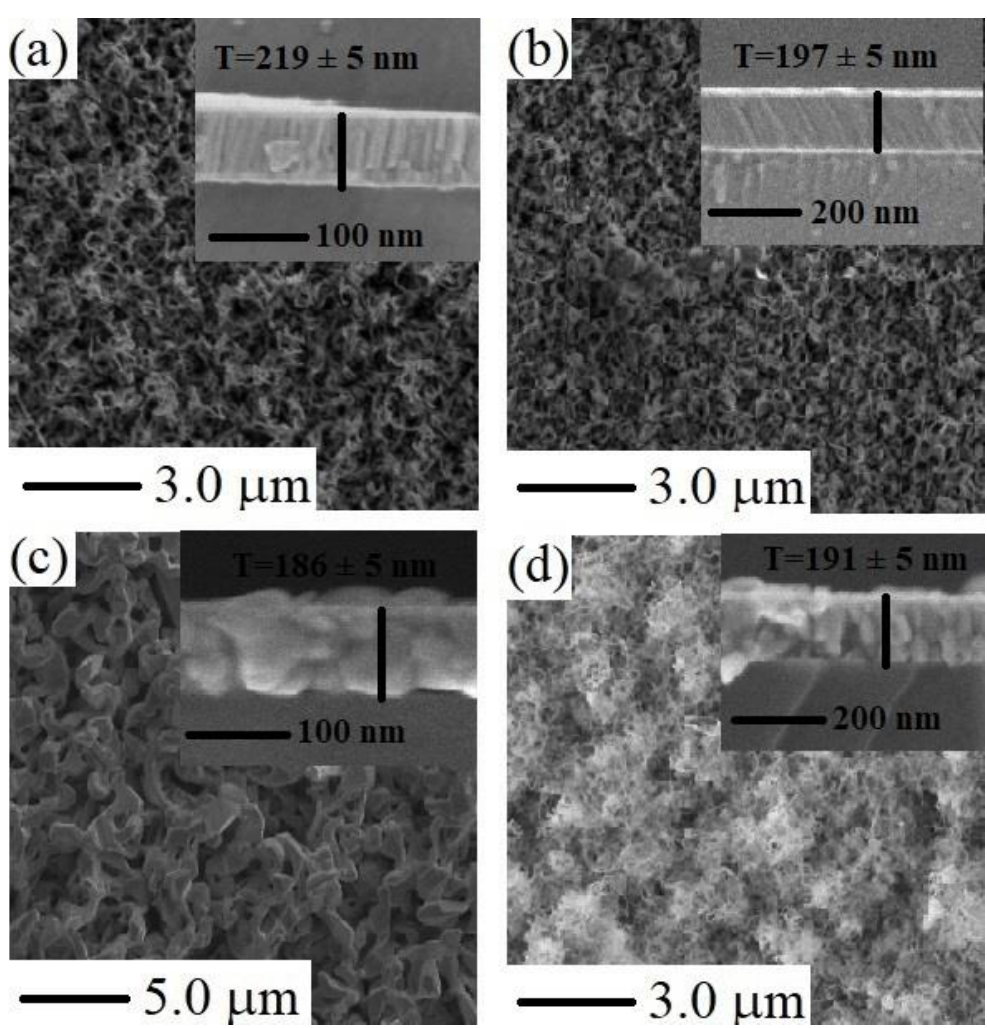
Figure 3. SEM images of ZnS thin films deposited at ( a ) 20 mm, ( b ) 40 mm, ( c ) 60 mm, and ( d ) 80 mm SSD. Insets show the cross-sectional zoom in micrographs of ZnS thin films for thickness measurement.